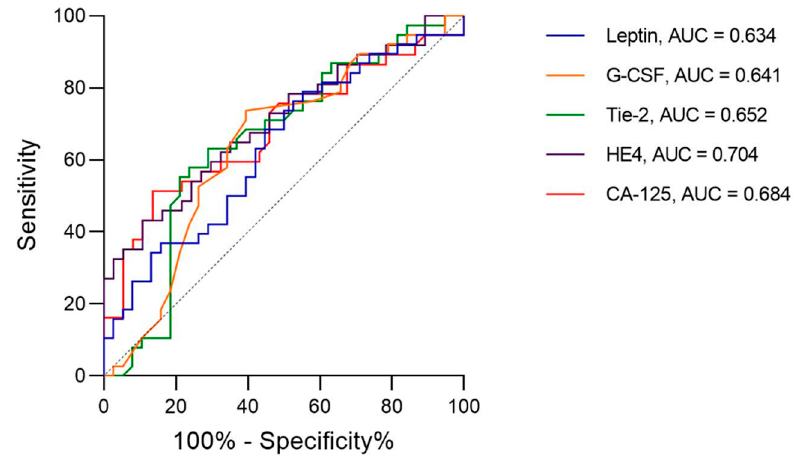
Figure 3. Diagnostic receiver operating characteristic (ROC) curves with area under the curve (AUC) values for three angiogenic biomarkers compared to CA-125 and HE-3.